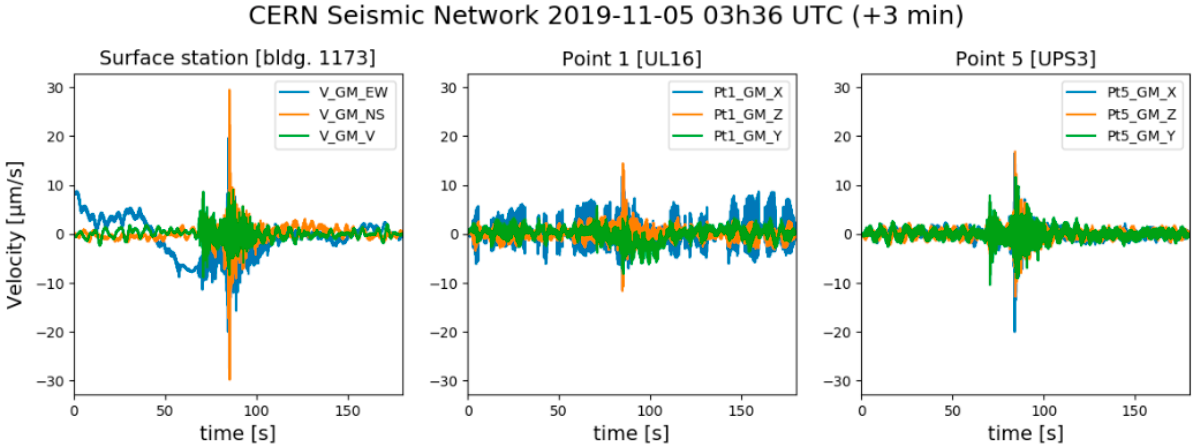
Figure 8. Velocity data plot registered by three CERN seismic stations between 03:36 and 03:39 (UTC) on 6 November 2019.